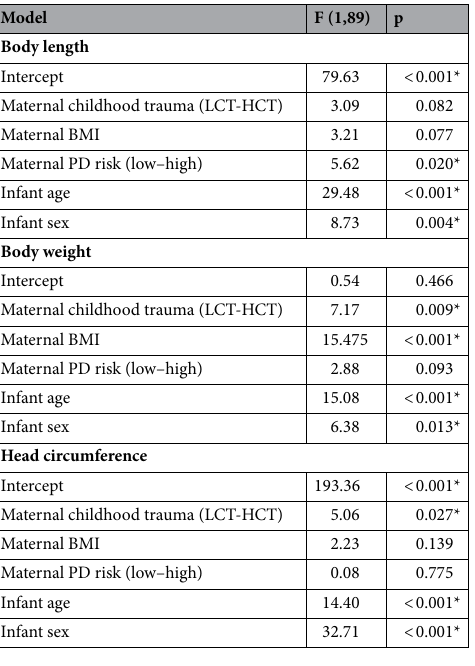
Table 5. Results of univariate analysis of MANCOVA models for body parameters at the age of 12 months. Significant effects